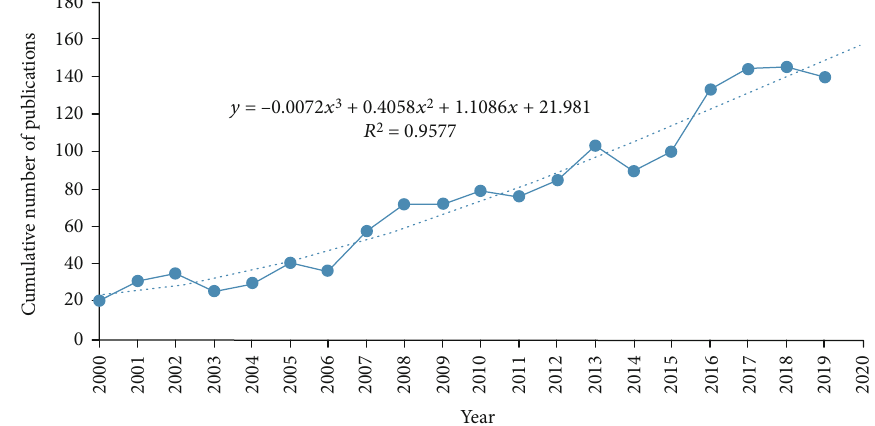
Figure 1: The number of annual publications on neuropathic pain rehabilitation research from 2000 to2019 and establish a time trend citation curve.